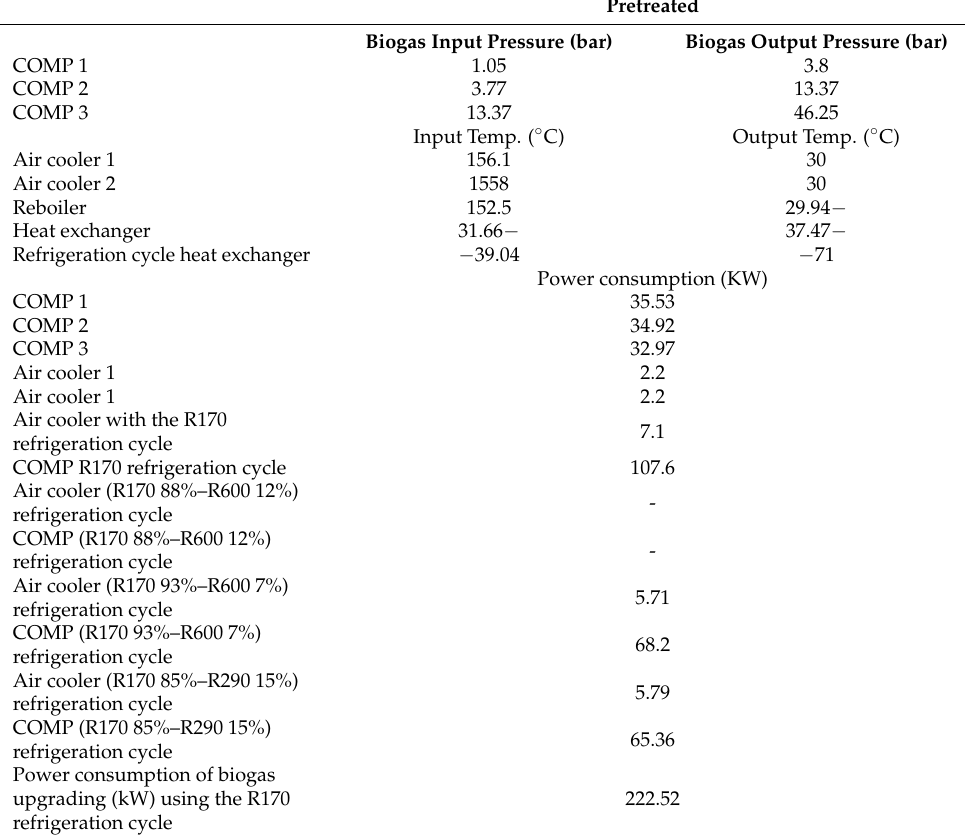
Table 8. Equipment conditions in biogas upgrading process- cryogenic